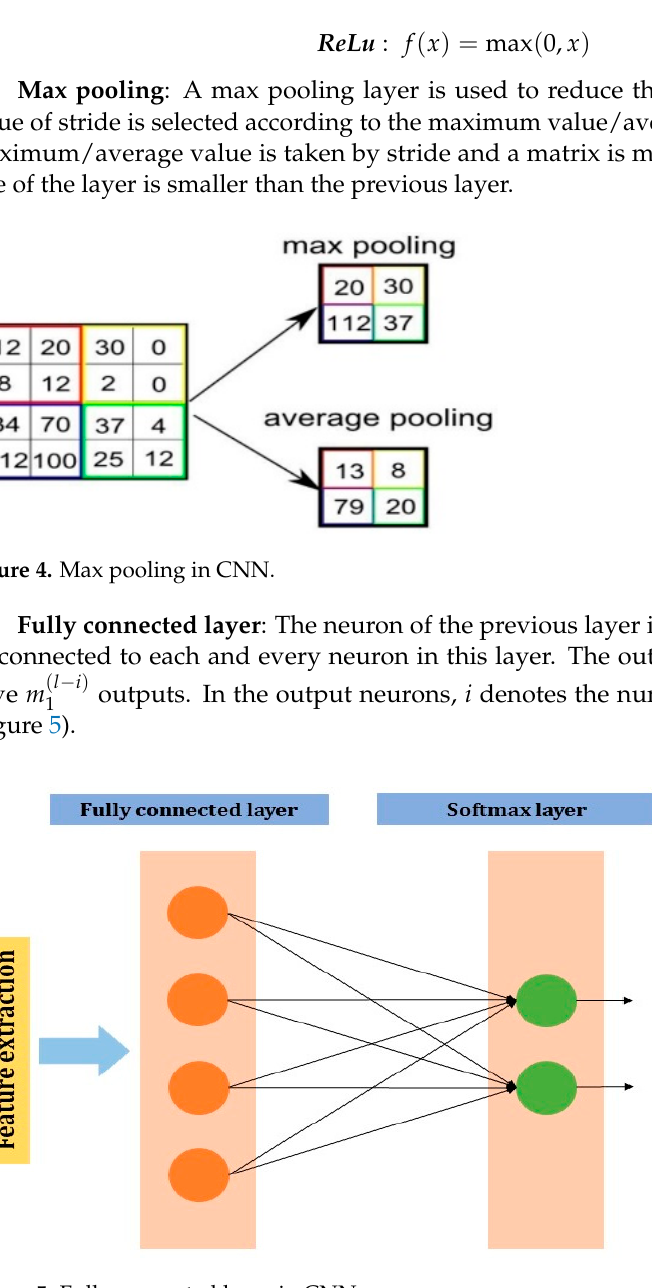
Figure 6. The architecture of RNN.